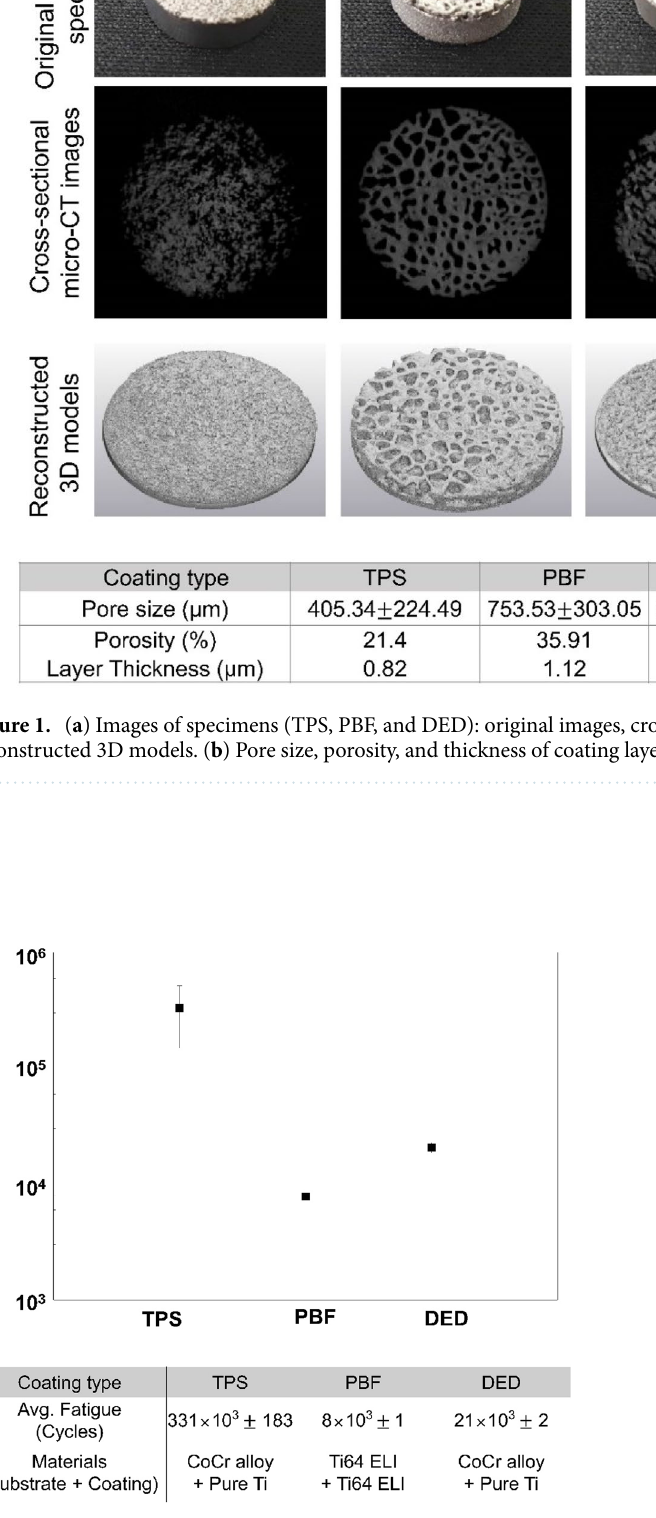
Figure 2. Fatigue life of TPS, PBF, and DED